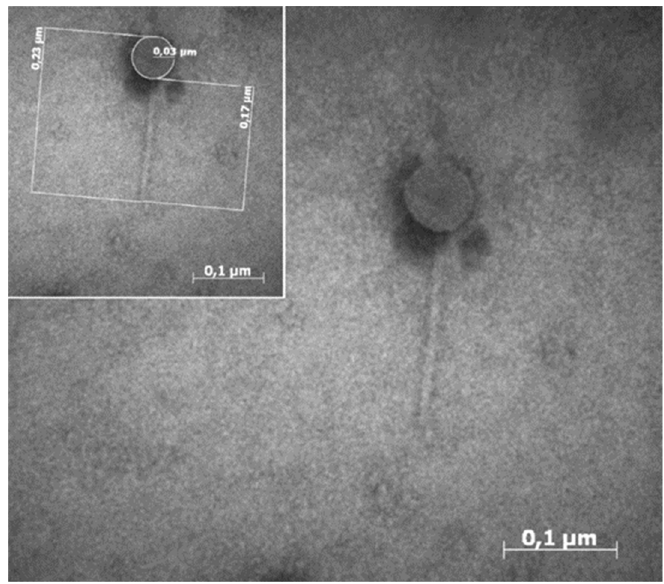
Figure 1. Φ IZSAM-1 under transmission electron microscope observation (50,000 × ) (integration Figure 1. ɸ IZSAM-1 under transmission electron microscope observation (50,000×) (integration from the source Aprea et al., 2015) from the source Aprea et al., 2015) [11].